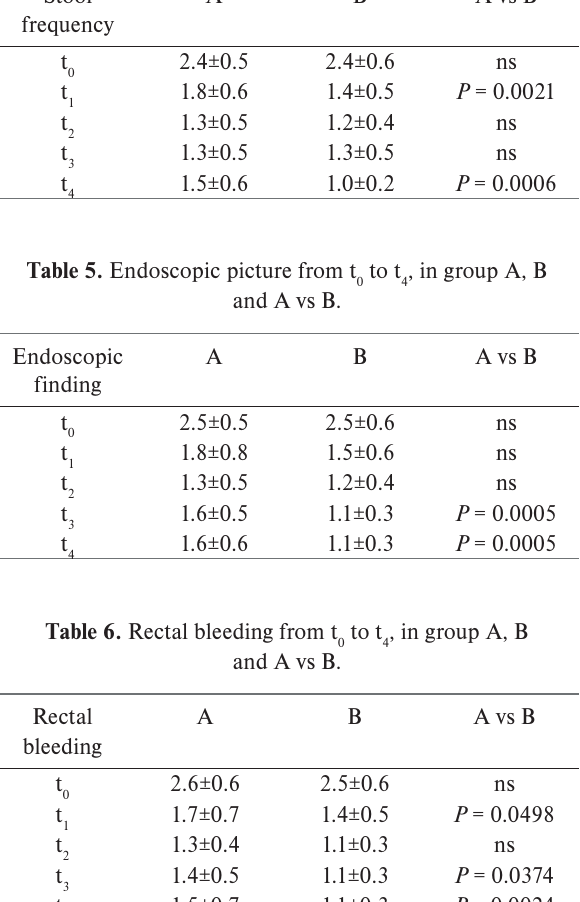
to t , in group a, B 0 4